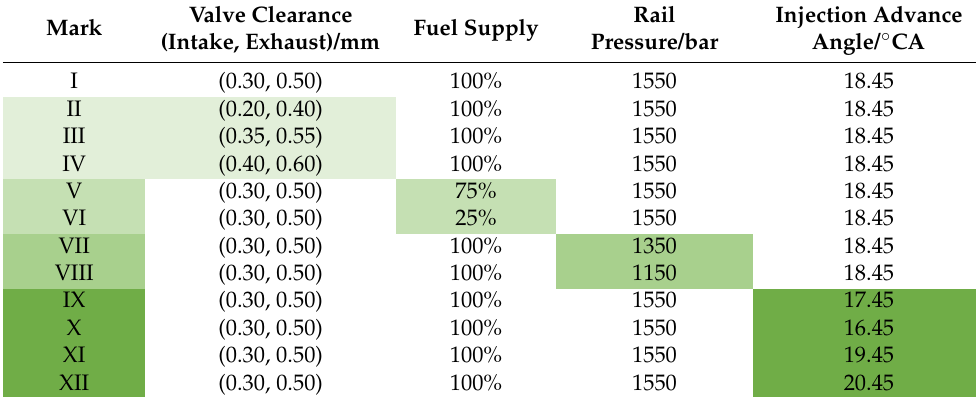
Table 4. Fault type and degree parameter setting (2300